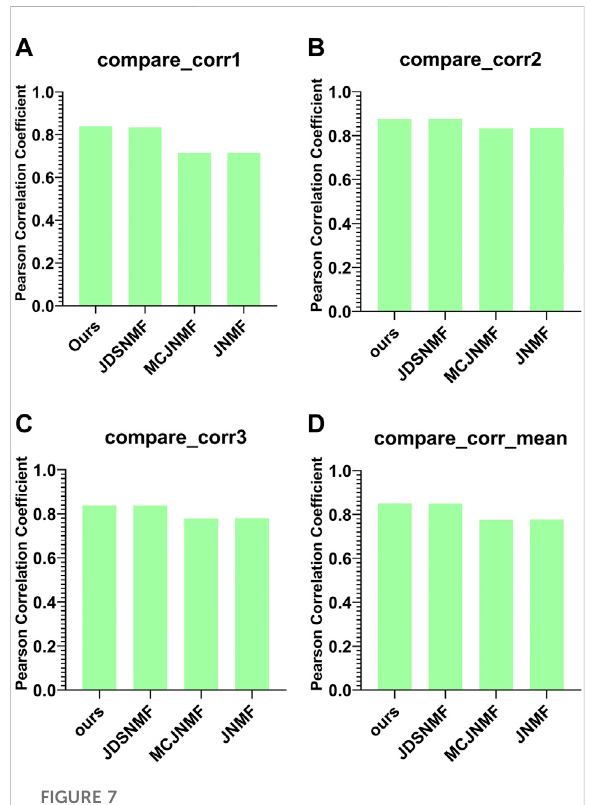
FIGURE 7 Comparison of reconstruction capabilities of the four algorithms. (A – C) are histograms of the Pearson correlation coef fi cients of the four algorithms between X i and UH i same experimental conditions (D) . The histogram of the mean comparison of the Pearson correlation coef fi cients in the fi rst three